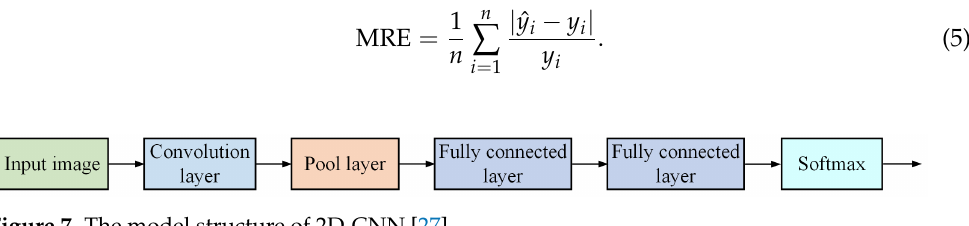
Figure 7. The model structure of 2D-CNN